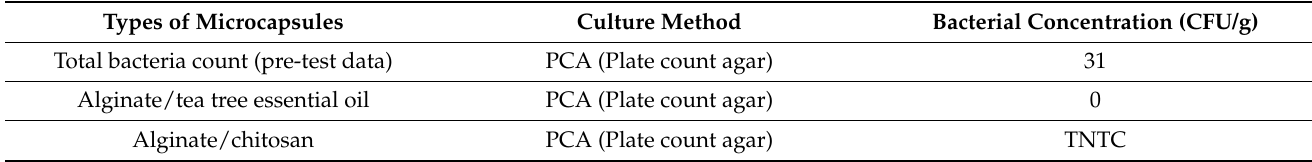
Table 6. The antibacterial effect of unused hot spring water by the microcapsules. Types of Microcapsules Culture Method Bacterial Concentration (CFU/g) Total bacteria count (pre-test data) PCA (Plate count agar) 31 Alginate/tea tree essential oil PCA (Plate count agar) 0 Alginate/chitosan PCA (Plate count agar) TNTC TNTC, too numerous to count; CFU, colony-forming